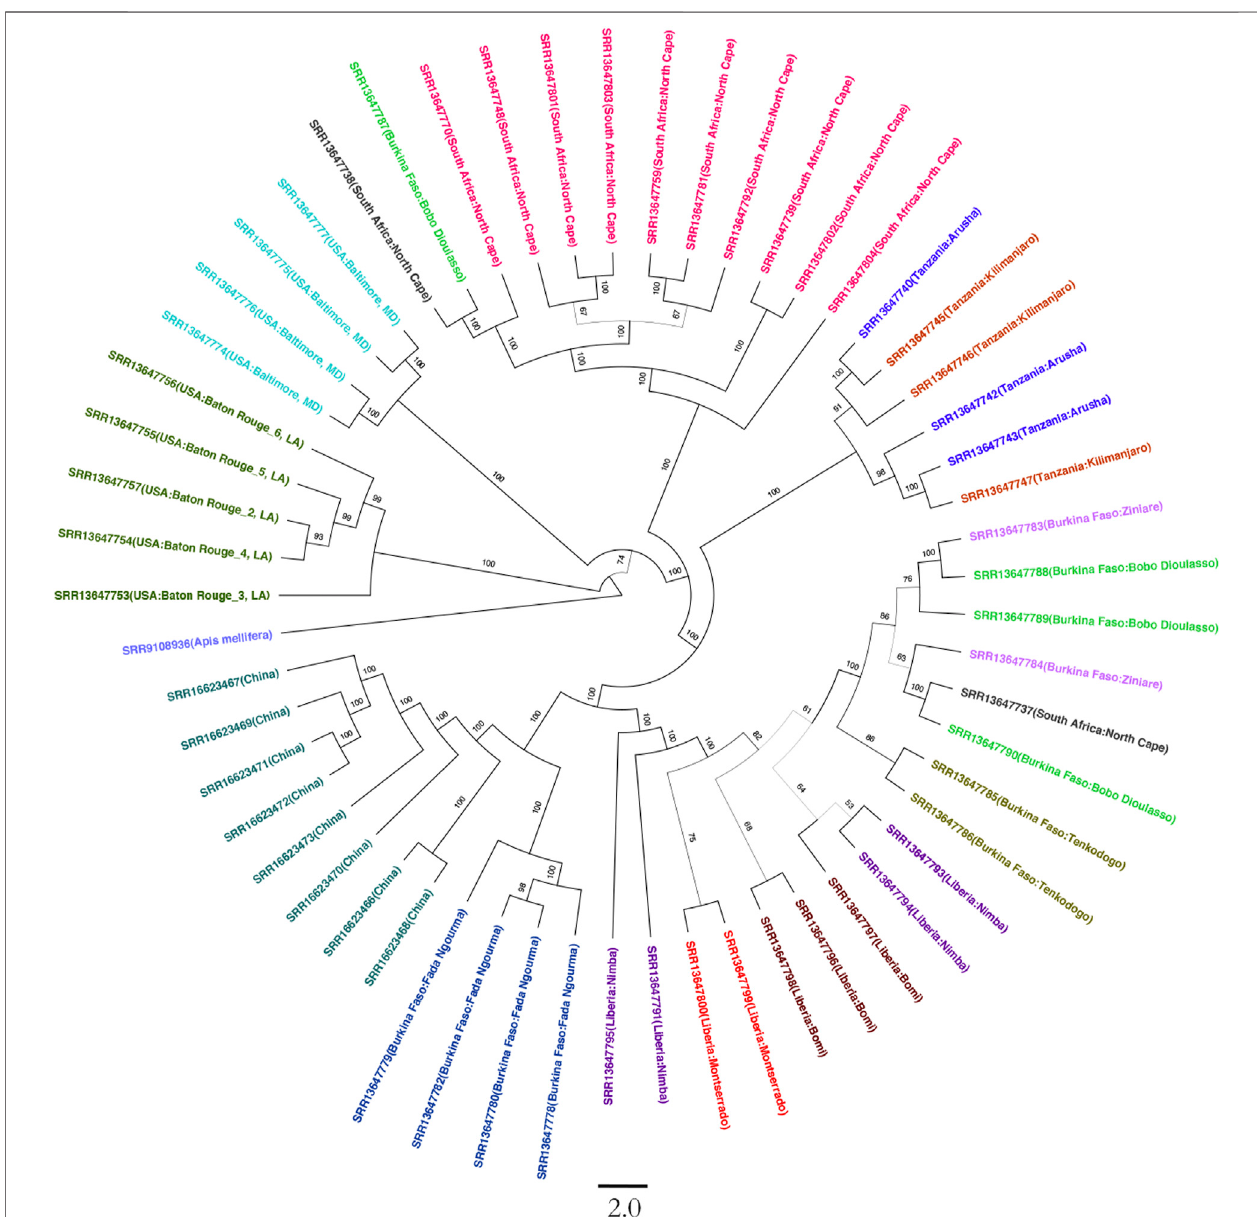
FIGURE 1 | Phylogenetic tree of 56 small hive beetles crossing native and novel regions. The tree was built on 4,541,776 SNPs along the genome. The beetles collected from the same region are highlighted with color. The beetles in the United States were clustered into two clusters. The beetles collected in China formed the deepestbranch,whichwascloselyrelatedtothoseinBurkinaFaso.Thevalueonthebranchindicatesthebootstrapcon fi dence.Honeybeewasusedasanoutgroupto root the tree. The scale bar for branch length is shown at the bottom.